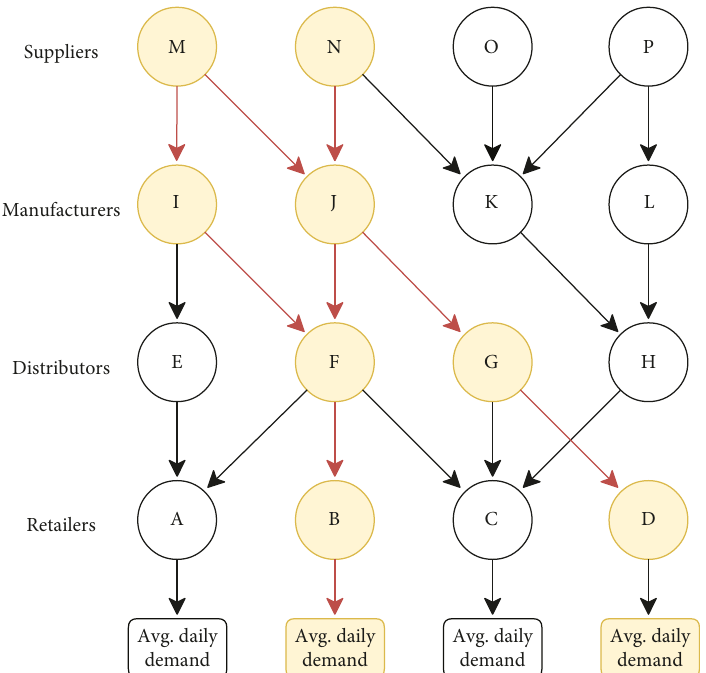
Figure 8: Path structure of a typical DMF-SCN.